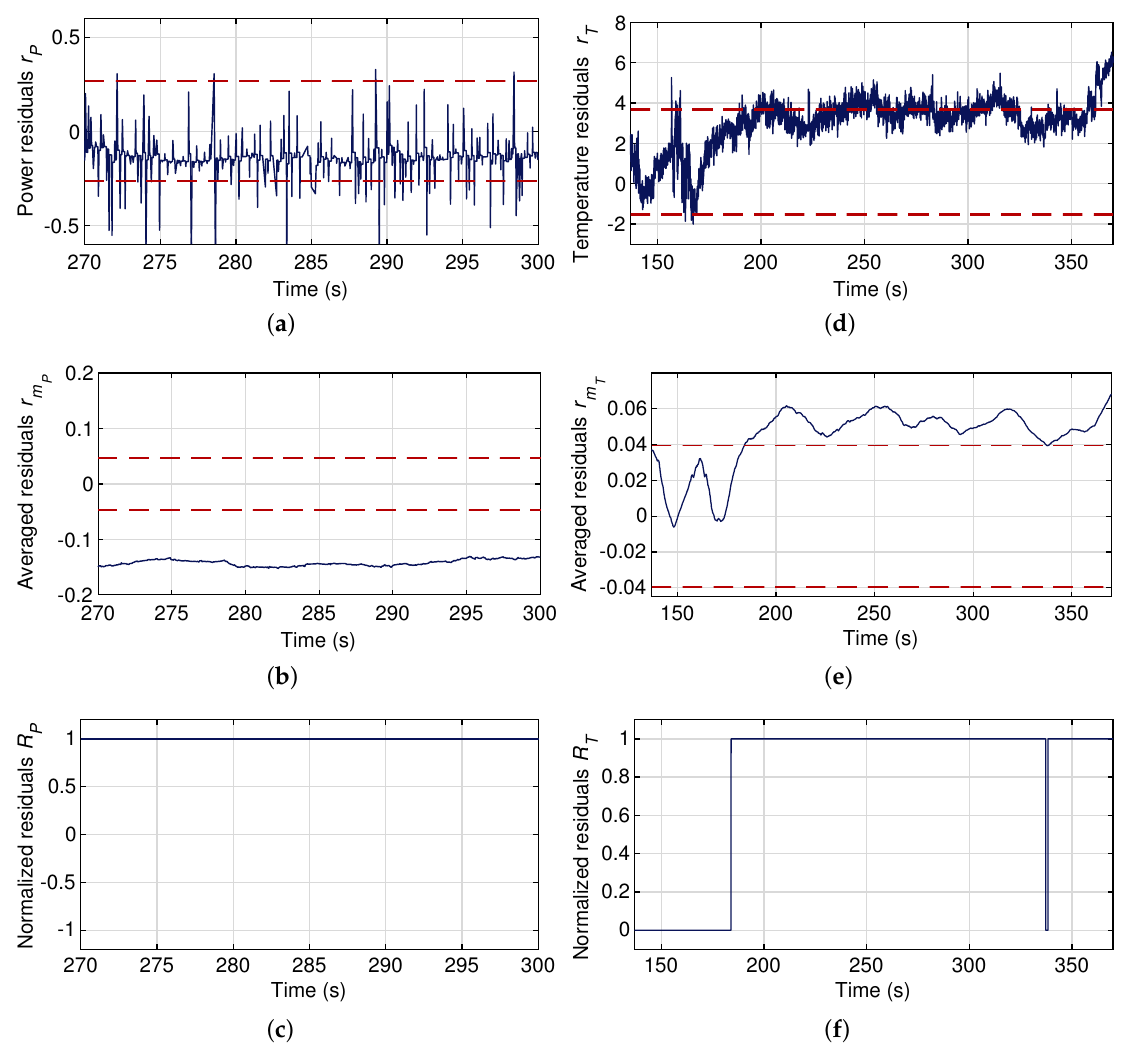
Figure 18. Power residuals assessment during faulty scenario of the introduction of an external component, and temperature residuals during the heating experiment. ( a ) Power raw residuals r P . ( b ) Power averaged residuals r m . ( c ) Power normalized residuals R P . ( d ) Temperature raw residuals P r T . ( e ) Temperature averaged residuals r m . ( f ) Temperature normalized residuals R T T